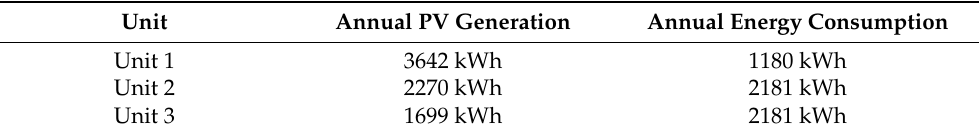
Table 9. Annual PV generation and energy consumption of the three